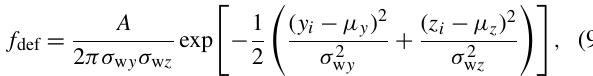
Table 3. Similar to Table 1 but for Strategy III